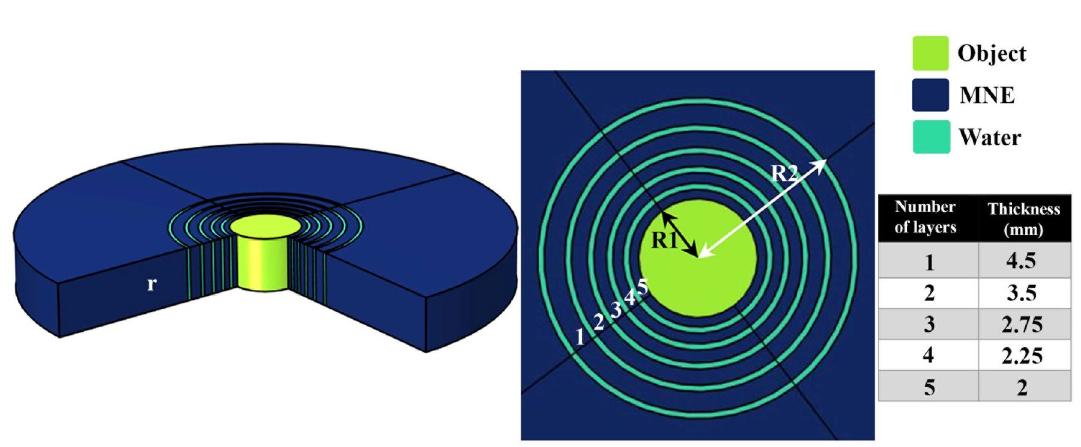
Figure 5. Schematic of composite lattice cloaking composed of natural materials in MNE substrate. The introduced cloaking structure consists of water and MNE layers. The water layers have a constant thickness of 1.4 mm and the thickness of the numbered MNE layers is shown in the